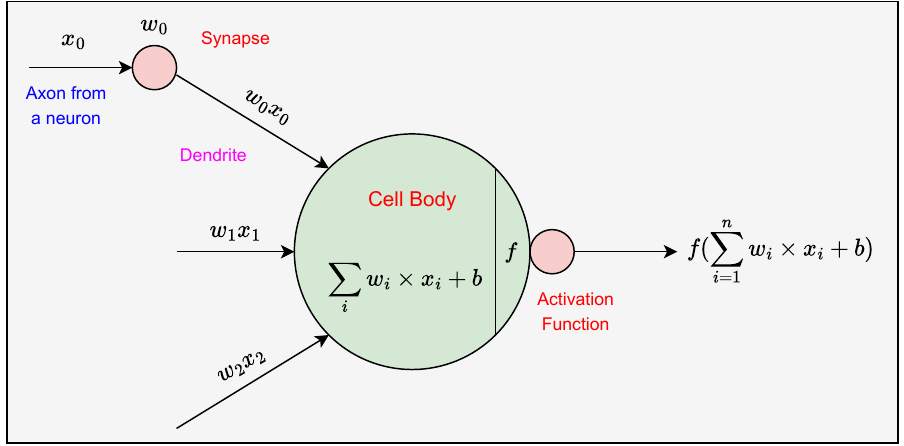
Figure 6. Activation function of